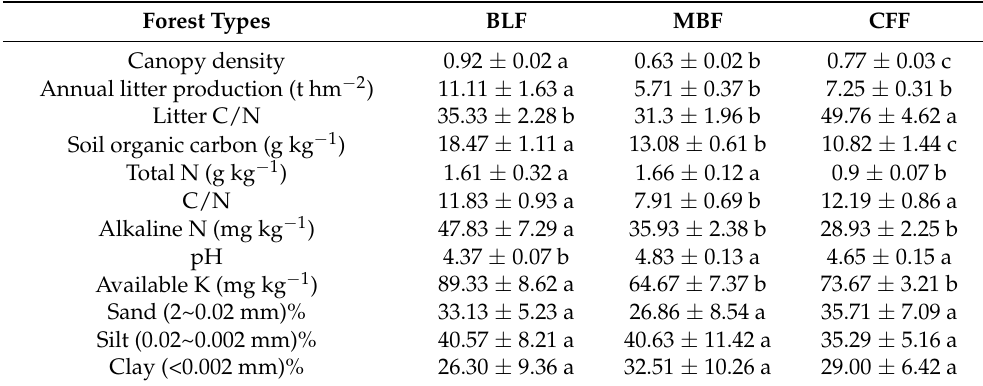
Table 2. Annual litter production and soil physical and chemical properties of different forest types (mean ±